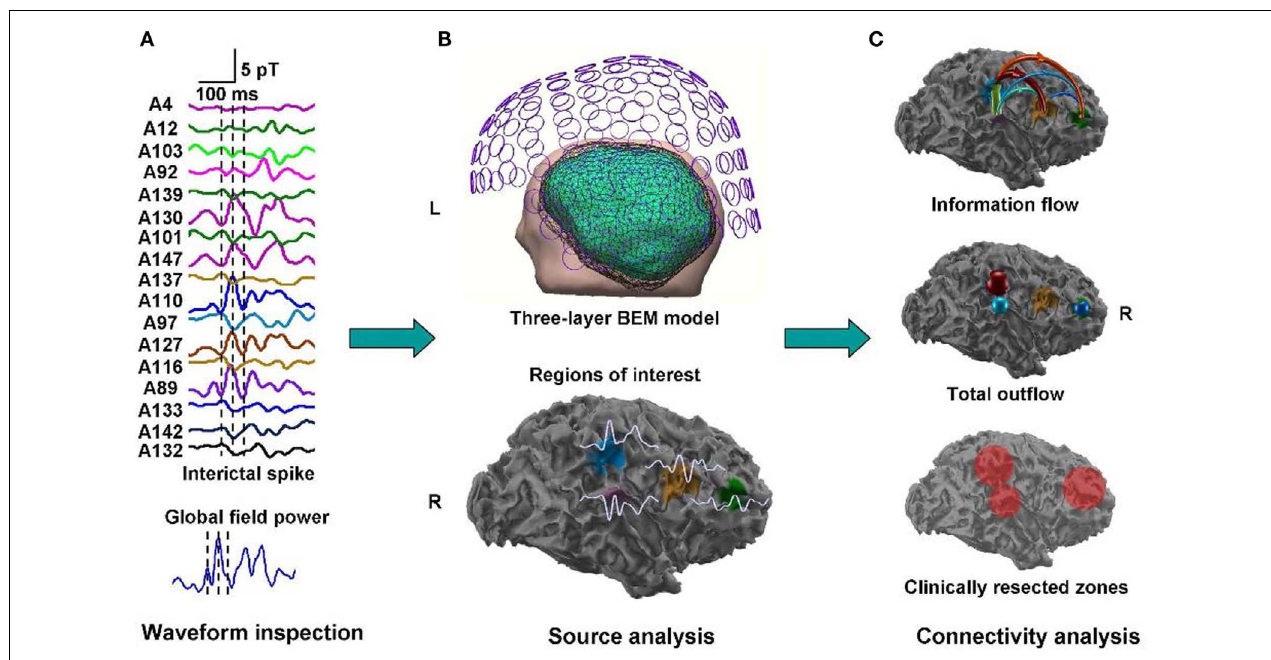
FIGURE 4 | Estimated direction of propagation of epileptiform activity along neuronal networks (Dai et al.,